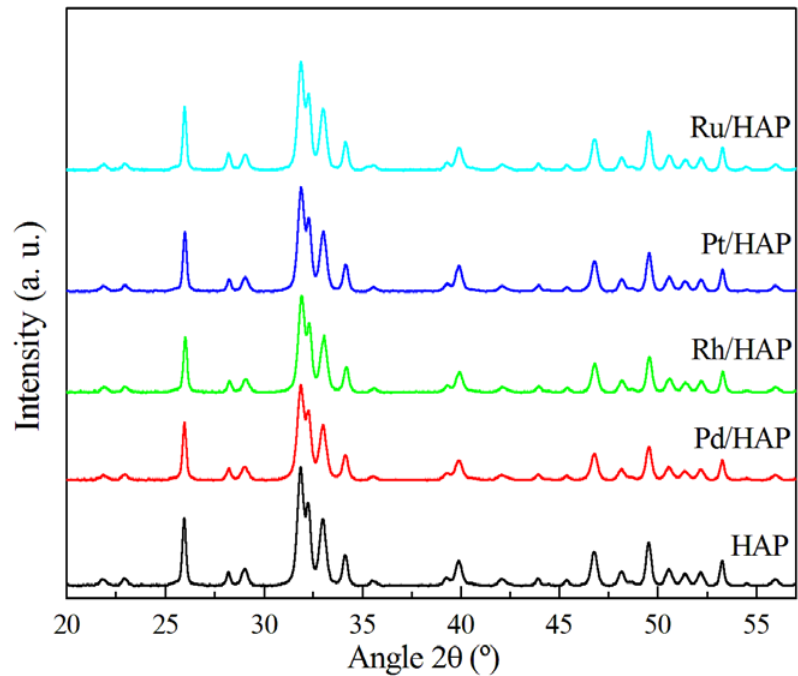
Figure 1. XRD patterns of the noble metal catalysts.